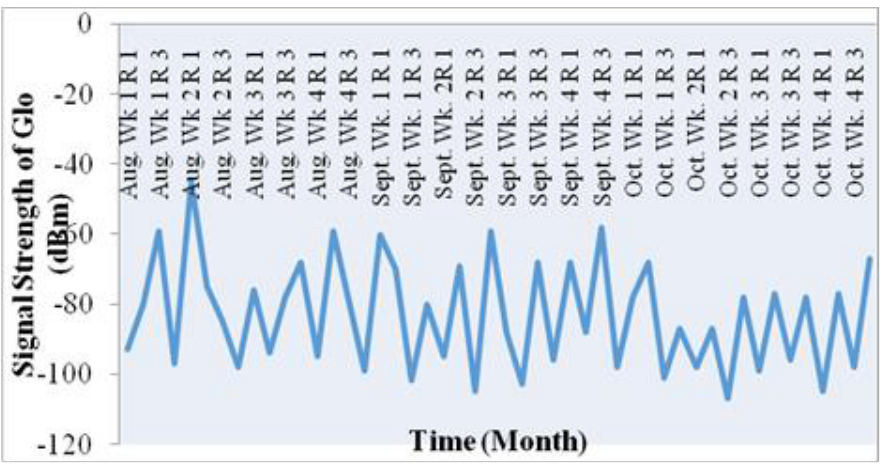
Figure 3: Graphical Representation of Received Signal Strength of Glo at EACOED, Oyo.